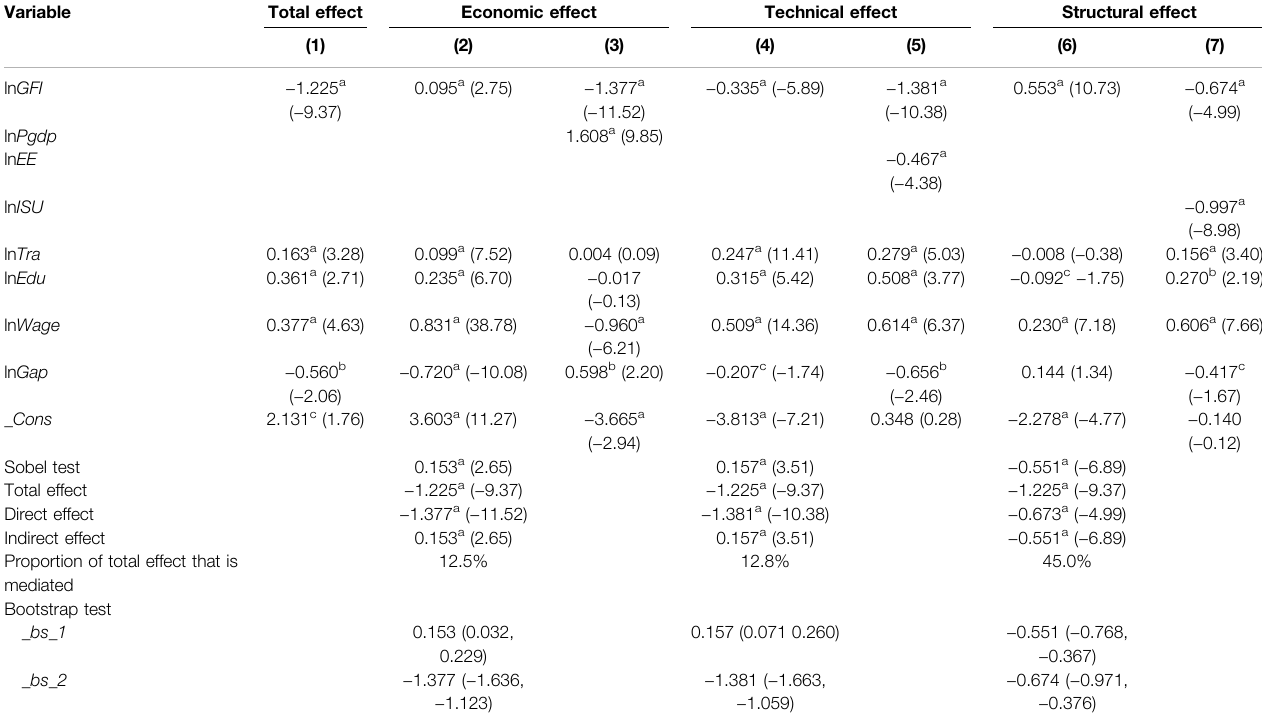
TABLE 7 | Estimated results of the mediation effects.